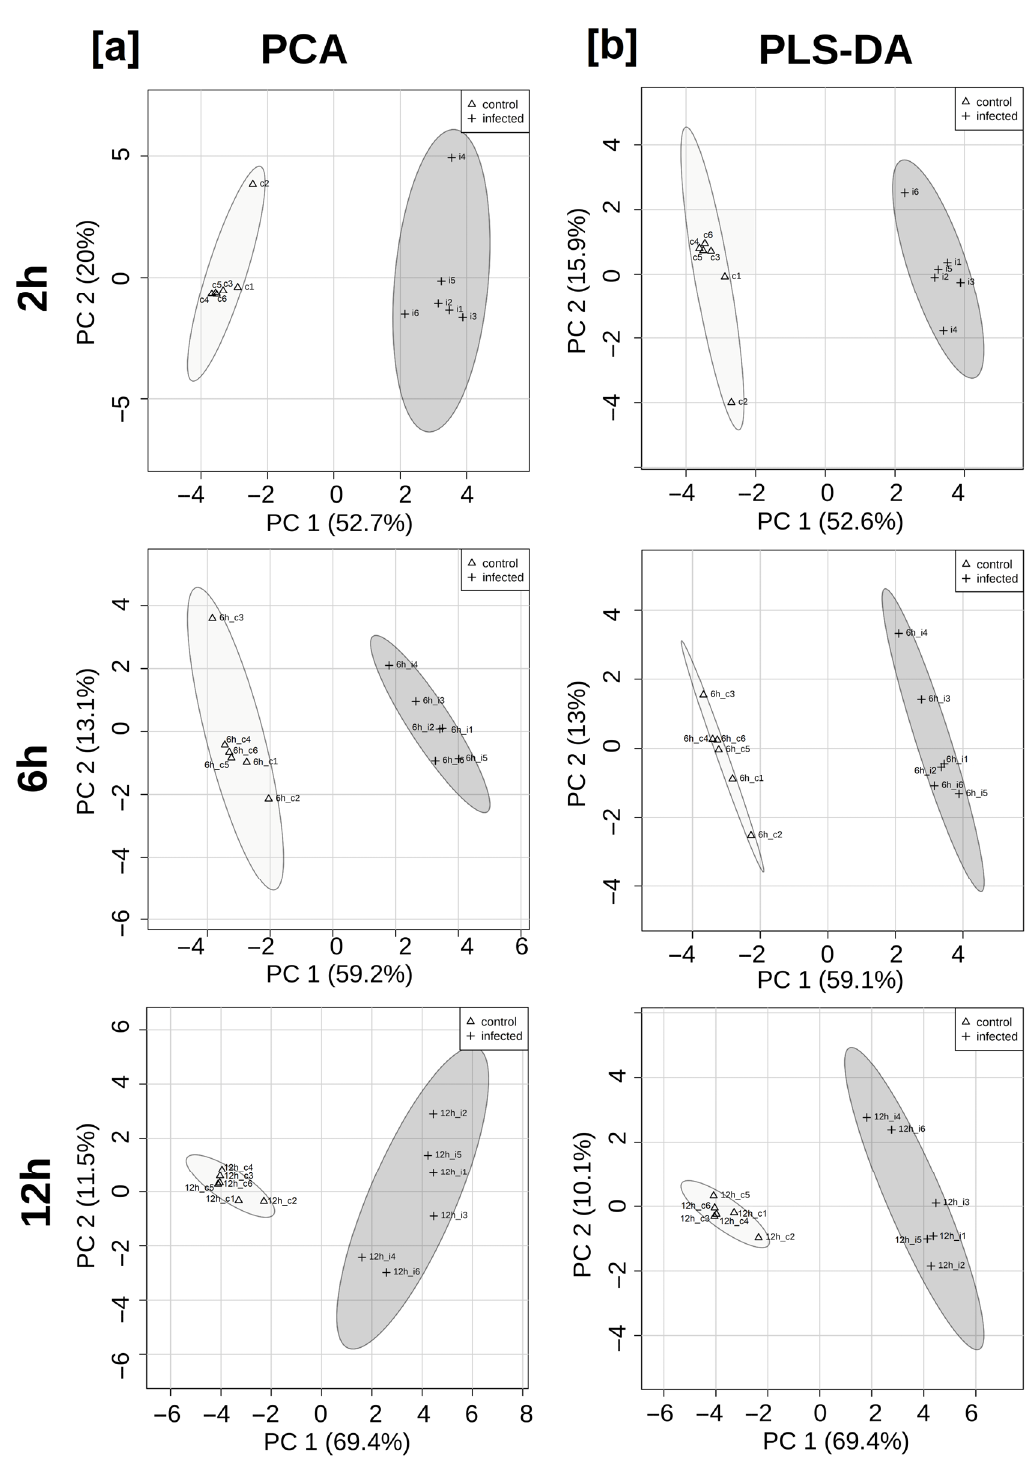
Figure 2. Summary of PCA and PLS-DA results. First and second principal components from PCA ( a ) and PLS-DA ( b ) after binning of the NMR spectra (all peaks, excluding water suppression region) of each time point: 2, 6, and 12 hpi. Accounted variability of each parameter is shown in brackets. Ellipses represent the 95% confidence interval for each group, control (triangle), and infected (plus) cells.